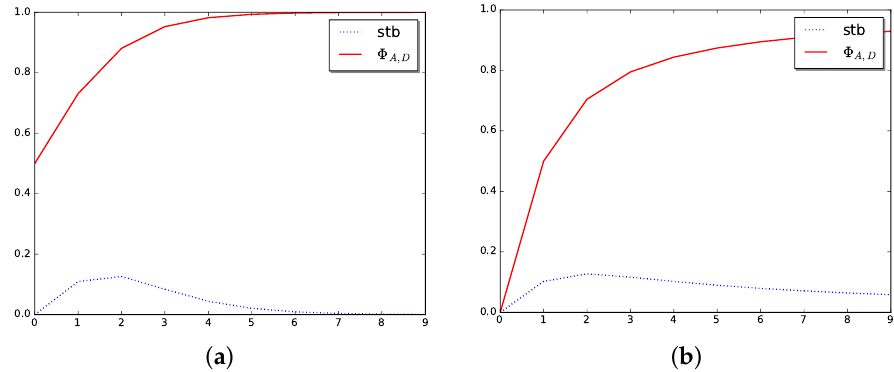
Figure 3. Stabilizer Stb ( λ ) in dimension one. ( a ) Stabilizer for logistic function. ( b ) Stabilizer for arctangent